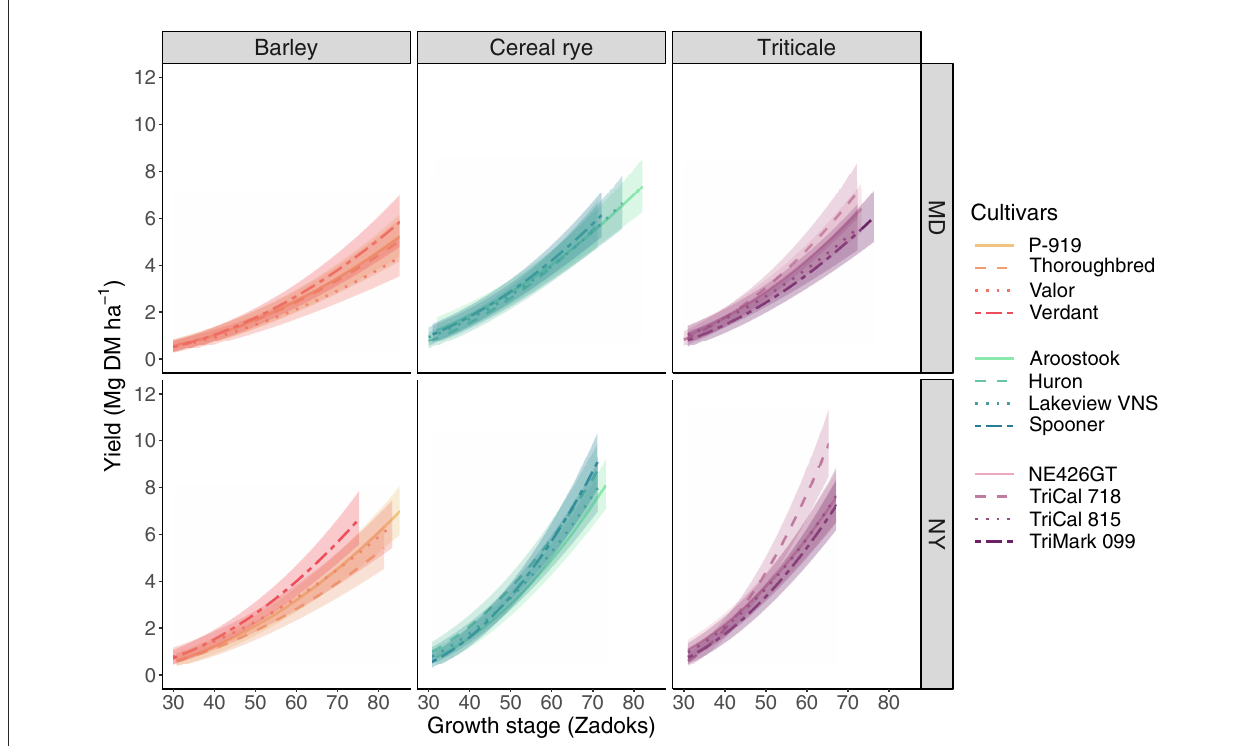
FIGURE2 The effect of winter cereal cultivar (four per species), growth stage (Zadoks), and site (MD and NY) on yield (Mg dry matter ha − 1 ). Yield has been back- transformed from the square root transformation. The shaded “ribbon” accompanying each cultivar slope (line) represents a 95% confidence interval. Analysis of variance and coefficients of determination for this linear mixed-effects model are presented in Table 2.